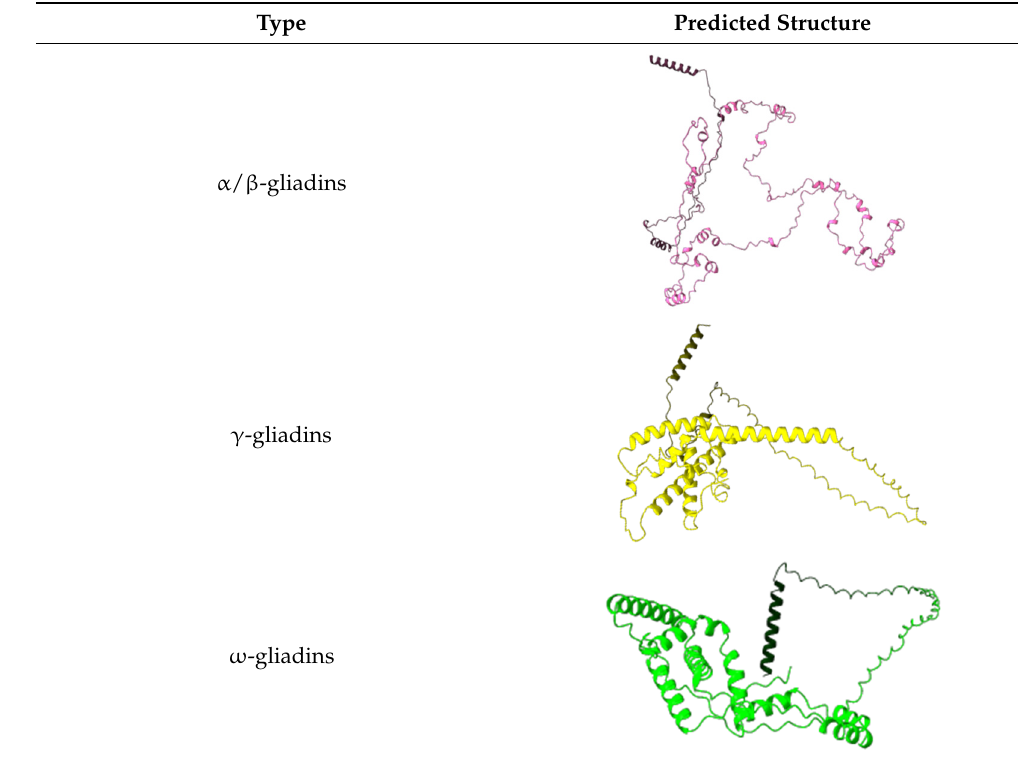
Table 1. Predicted structure of gliadins.